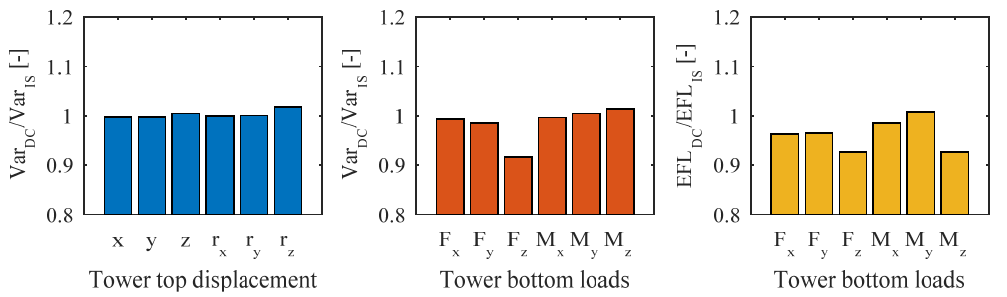
Figure 16. Response of tower top displacements and tower bottom loads for wind speed of 20ms − 1 and DC